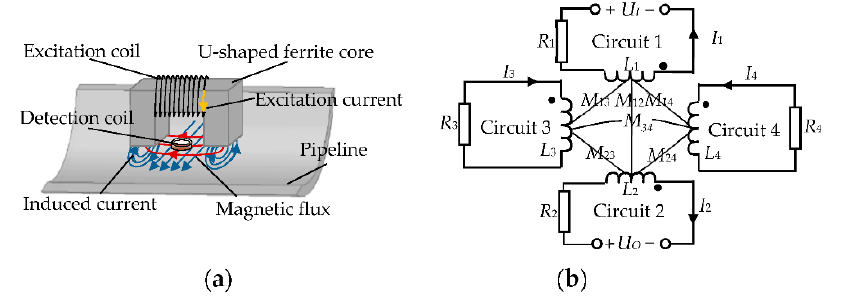
Figure 1. The detection principle of balanced-field electromagnetic technique: ( a ) Schematic diagram of the electromagnetic distribution on the surface of the pipeline; ( b ) Mutual inductance model for the detection of balanced-field electromagnetic technique.